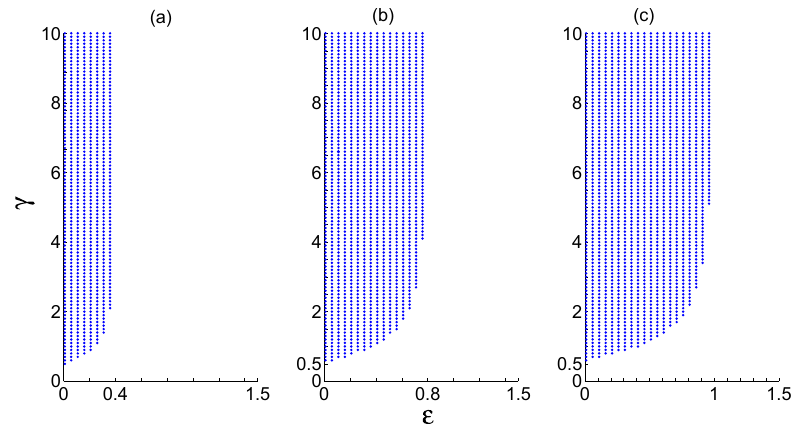
Figure 3. Stability region for homogeneous system ( τ(t) = 0), as a function of (ε,ξ,γ) for fixed values of ξ . (a) ξ = 0 . 4, (b) ξ = 0 . 8, and (c) ξ = 1. The necessary and sufficient conditions are satisfied.